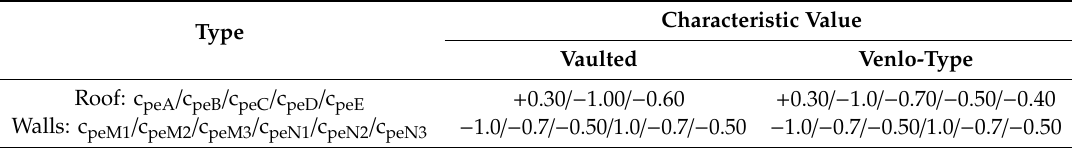
Figure 12. Zones for global pressure coefficients for walls and single- and multi-span roof: (a) vaulted greenhouse; (b) Venlo-type greenhouse. Table 4. External pressure coefficients.